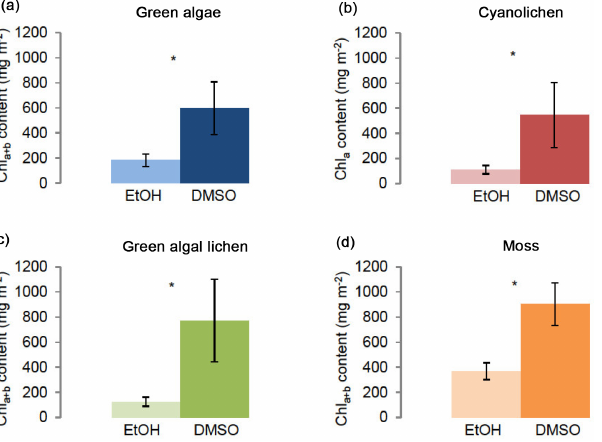
Figure 2. Chlorophyll a + b /chlorophyll a content (mgm − 2 ) de- pending on preparatory grinding in a dry state ( G DRY ) as com- pared to control extractions without grinding (NG).